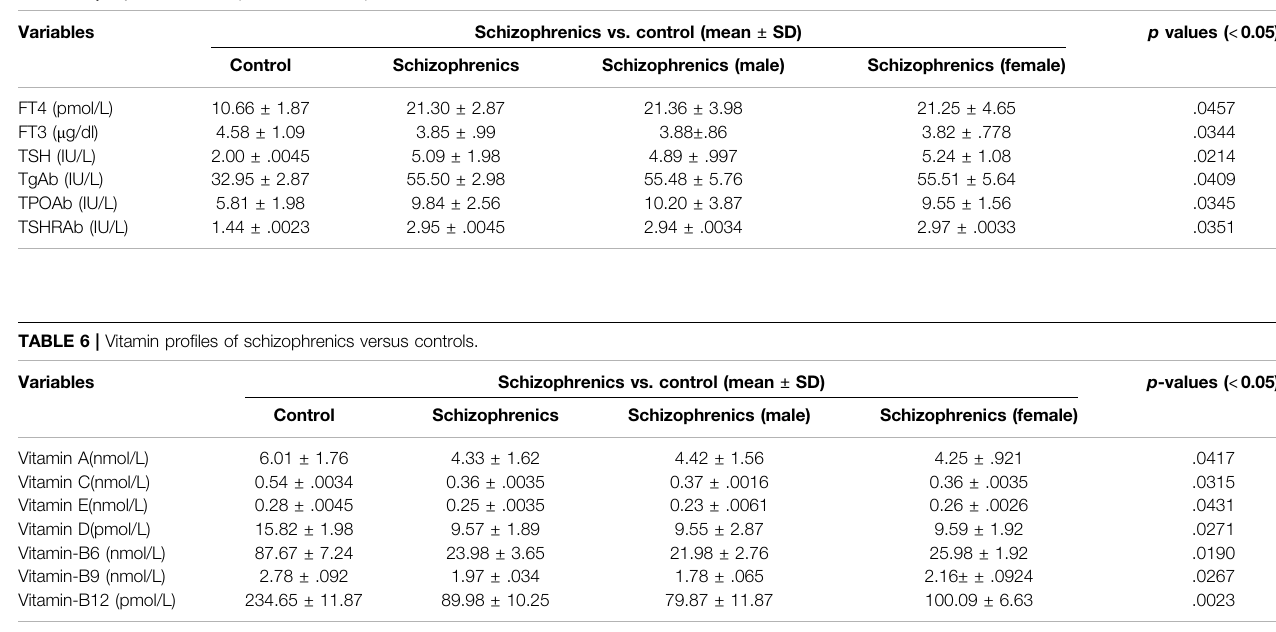
TABLE 5 | Thyroid hormone pro fi les of schizophrenics versus controls.